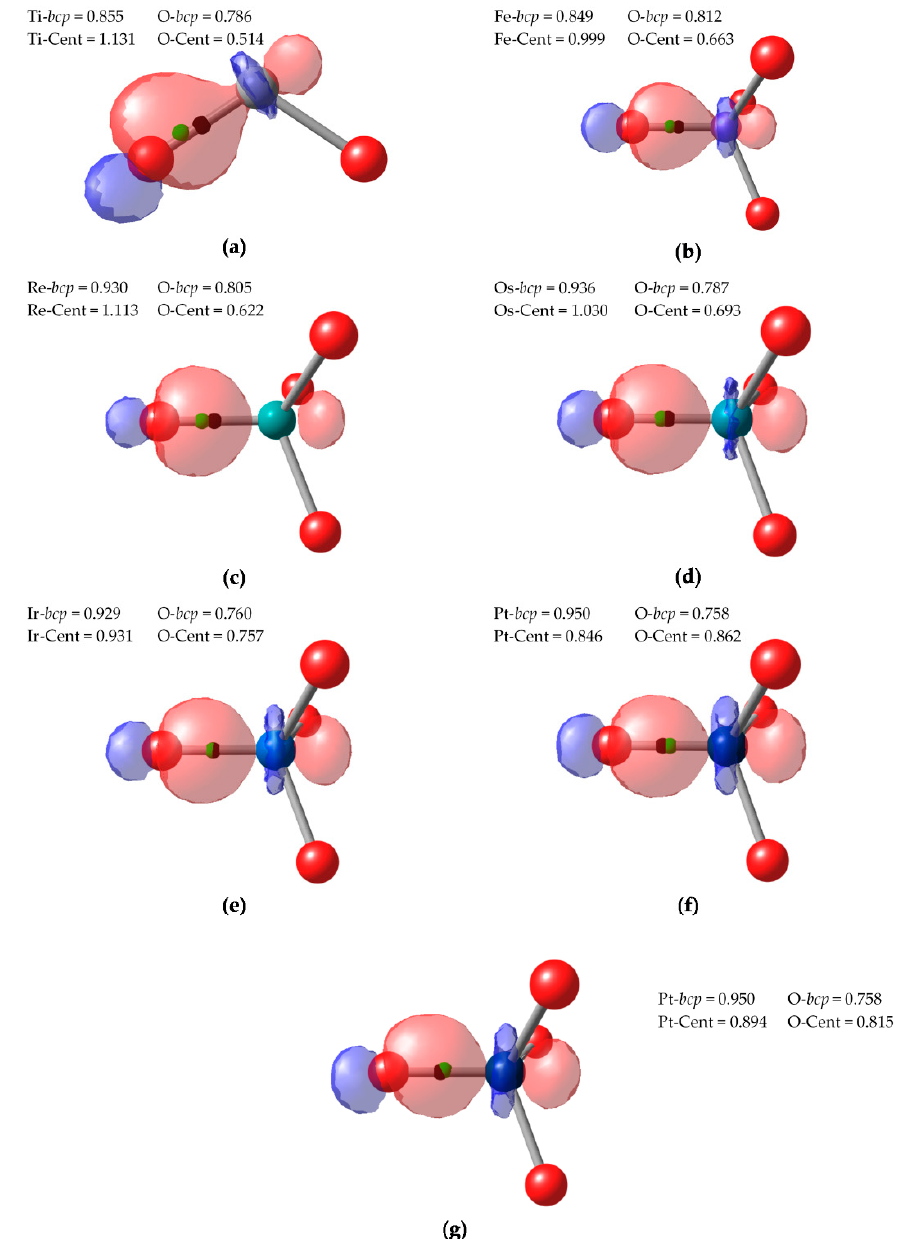
Figure 5. TM-O σ -type NLMO isocontour plot (0.1) for TiO 2 ( a ), FeO 42 − ( b ), ReO 4 − ( c ), OsO 4 ( d ), IrO 4 +